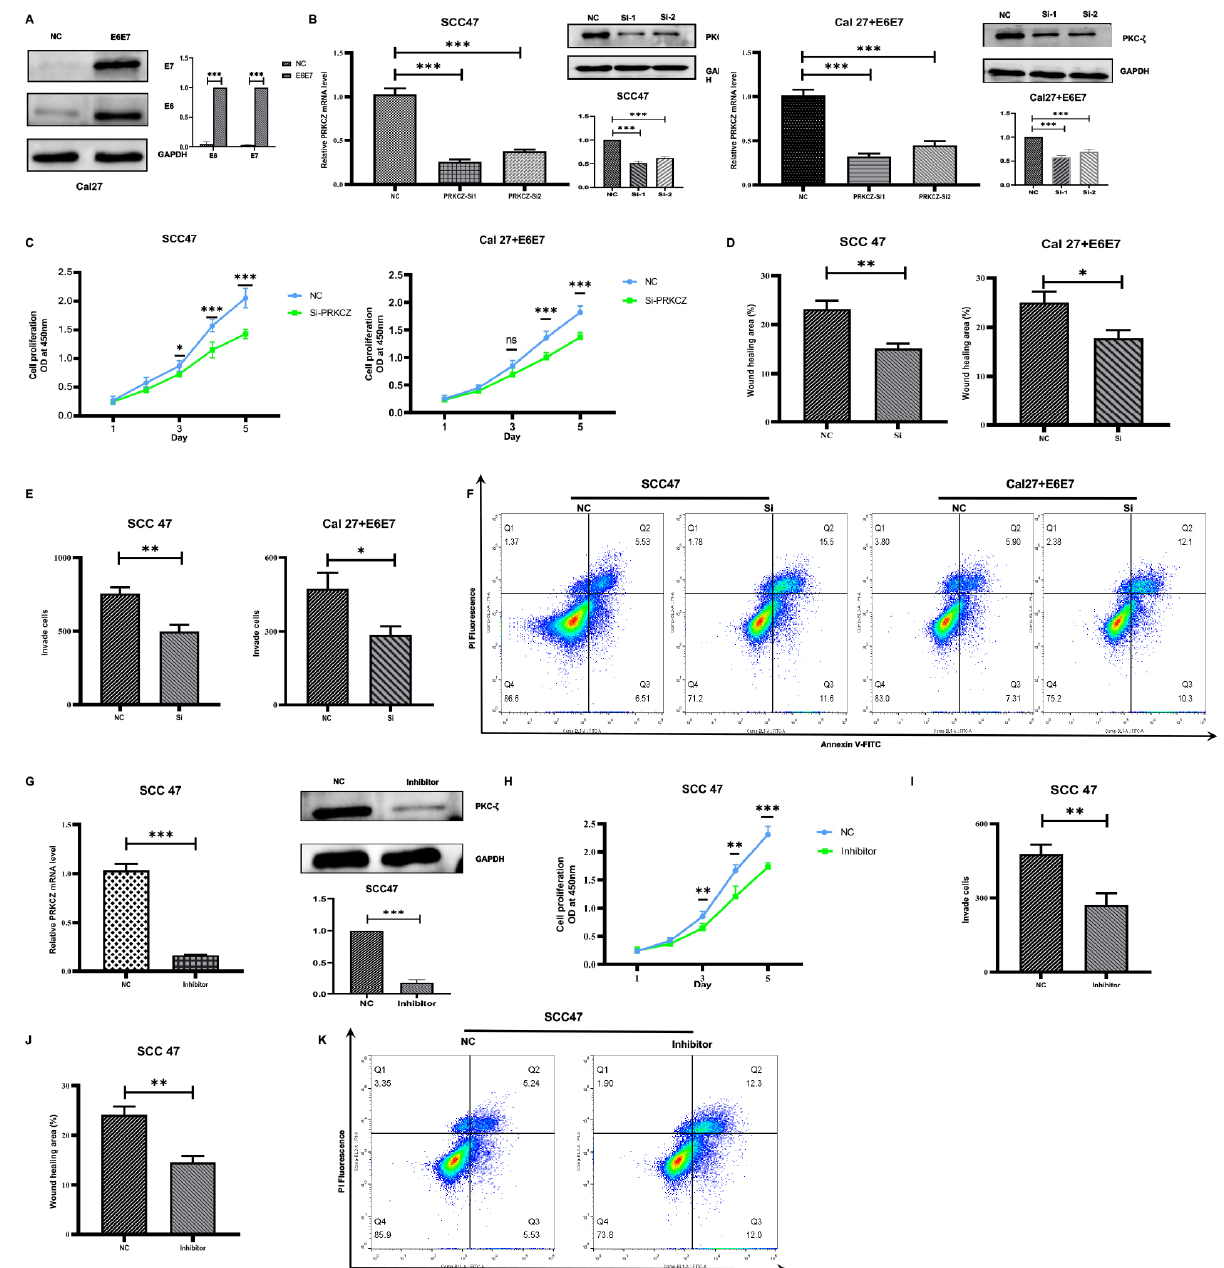
Figure 3. The effect of PRKCZ on biological behaviors of HPV+ HNSCC cell lines. ( A ) Transfection efficiency of E6 and E7 lentivirus plasmids (include densitometry analysis of WB results). ( B ) Trans- fection efficiency of PRKCZ siRNAs (include densitometry analysis of WB results). ( C ) Silencing PRKCZ effects on proliferation abilities of HPV+ HNSCC cell lines. ( D ) Silencing PRKCZ effects on migration abilities of HPV+ HNSCC cell lines. ( E ) Silencing PRKCZ effects on invasion abilities of HPV+ HNSCC cell lines. ( F ) Silencing PRKCZ effect on cell apoptosis of HPV+ HNSCC cell lines. ( G ) Inhibition efficiency of PKC- ζ pseudosubstrate inhibitor (include densitometry analysis of WB results). ( H ) The role of PKC- ζ pseudosubstrate inhibitor on proliferation abilities of HPV+ HNSCC cell lines. ( I ) The role of PKC- ζ pseudosubstrate inhibitor on migration abilities of HPV+ HNSCC cell lines. ( J ) The role of PKC- ζ pseudosubstrate inhibitor on invasion abilities of HPV+ HNSCC cell lines. ( K ) The role of PKC- ζ pseudosubstrate inhibitor on cell apoptosis of HPV+ HNSCC cell lines. All assays were carried out in triplicate. Results were presented as means ± SD. ns > 0.05, * p < 0.05, ** p < 0.01, *** p <